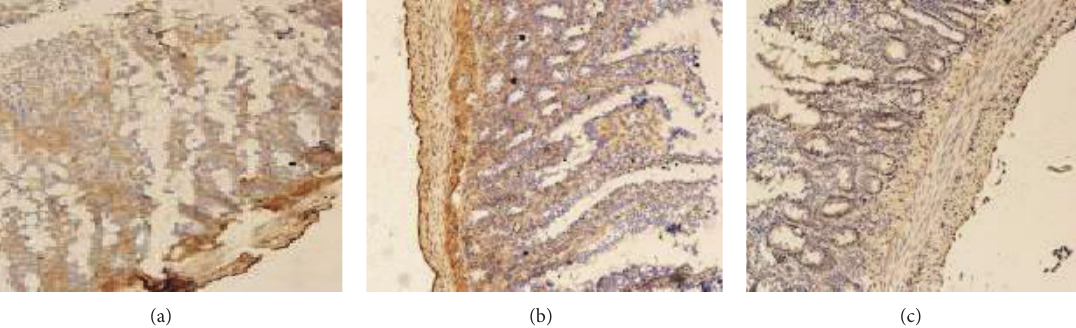
Figure 6: Laminin protein expression. A representative sample from the SBT group ( 𝑛 = 12 ): an absence of mucosal laminin protein expression and severe injury of intestinal villi are present. (b) A representative sample from the pre-SNP group ( 𝑛 = 14 ): lower mucosal laminin protein expression and mild injury of intestinal villi are observed. (c) Post-SNP group ( 𝑛 = 16 ): absence of mucosal laminin protein expression and severe injury of intestinal villi are observed ( × 200).